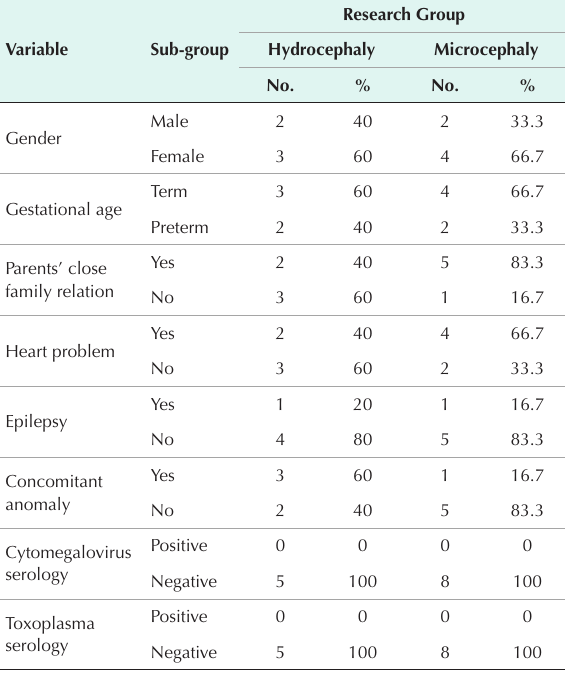
Table 4. Comparison of the 2 Research Groups in Terms of Qualitative